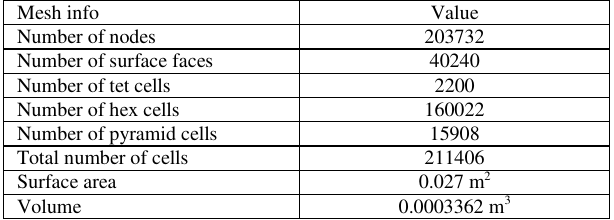
Fig. 6. The displaceable mesh of combustion volume for fuel spray simula- tion Table 3. The computational mesh